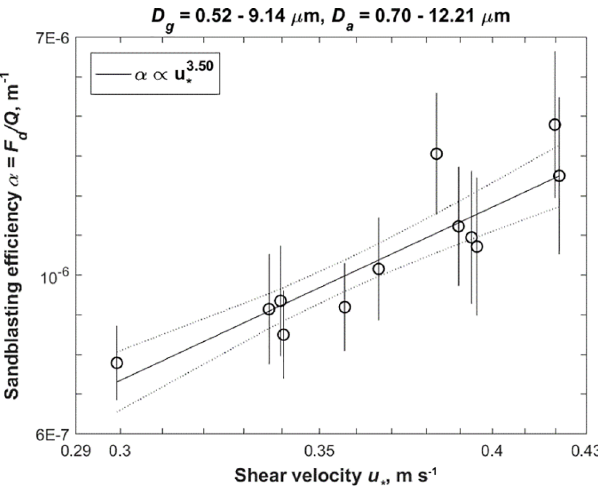
Figure 5. The bulk sandblasting efficiency α (m − 1 ) at Oceano as a function of shear velocity. The linear-least-squares fit (black line) indicates that α increases as a power law in shear velocity with an exponent of 3 . 50 ± 0 . 89. Error bars were obtained by propagating errors from the sensor intercalibration process, the regression used in the gradient method, and the subtraction of the sea-salt deposition flux (see Supplement). The two dotted black lines denote the 95% confidence range on the fit. The geometric and the aerodynamic di- ameter ranges of the vertical dust mass flux F d are noted at the top, and Q is the total horizontal sand flux integrated over all sand grain sizes (Martin et al.,